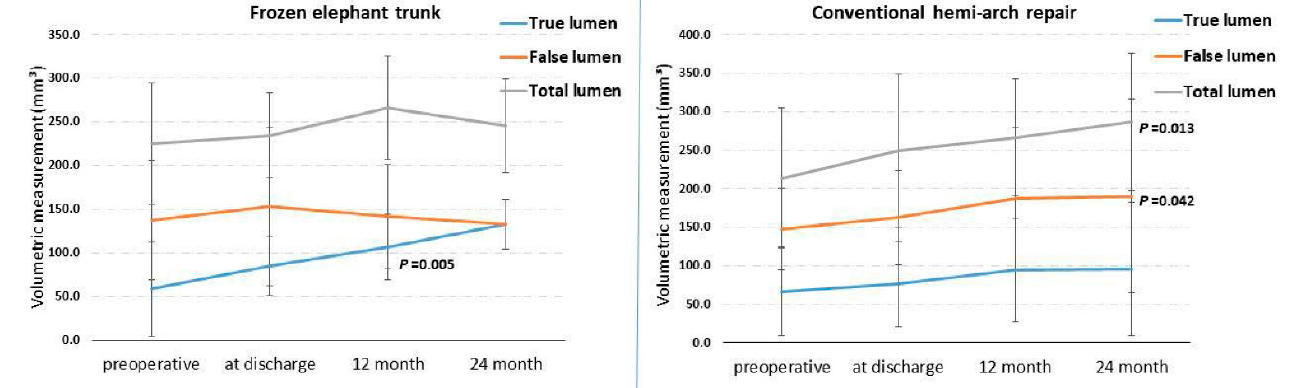
Figure 2. Median lumen in cm 3 at the respective time of measurement. were compared with the hemi-arch repair group at different time points (Table 2). The